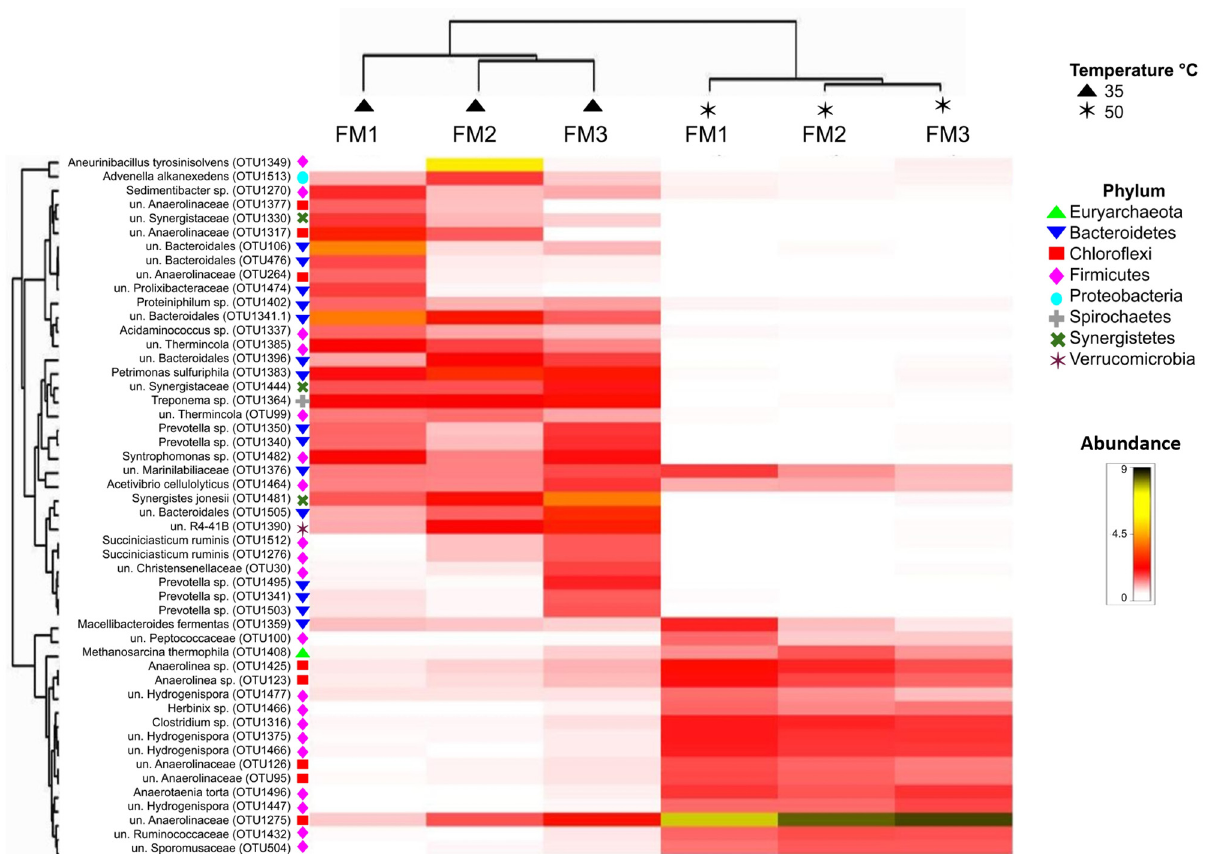
Figure 6. Shade matrix plot (Primer 7) showing relationship among clusters of samples (Bray–Curtis similarity from the standardized and square-root-transformed abundance data). A cluster of 50 most important standardized OTUs was grouped using Whitaker Index of association, independently. Color shading intensity within the matrix indicates the transformed relative abundance of each taxon. Symbols on the sample axis refer to the temperature used in the digestion and on the y-axis indicate the phyla of each genus.